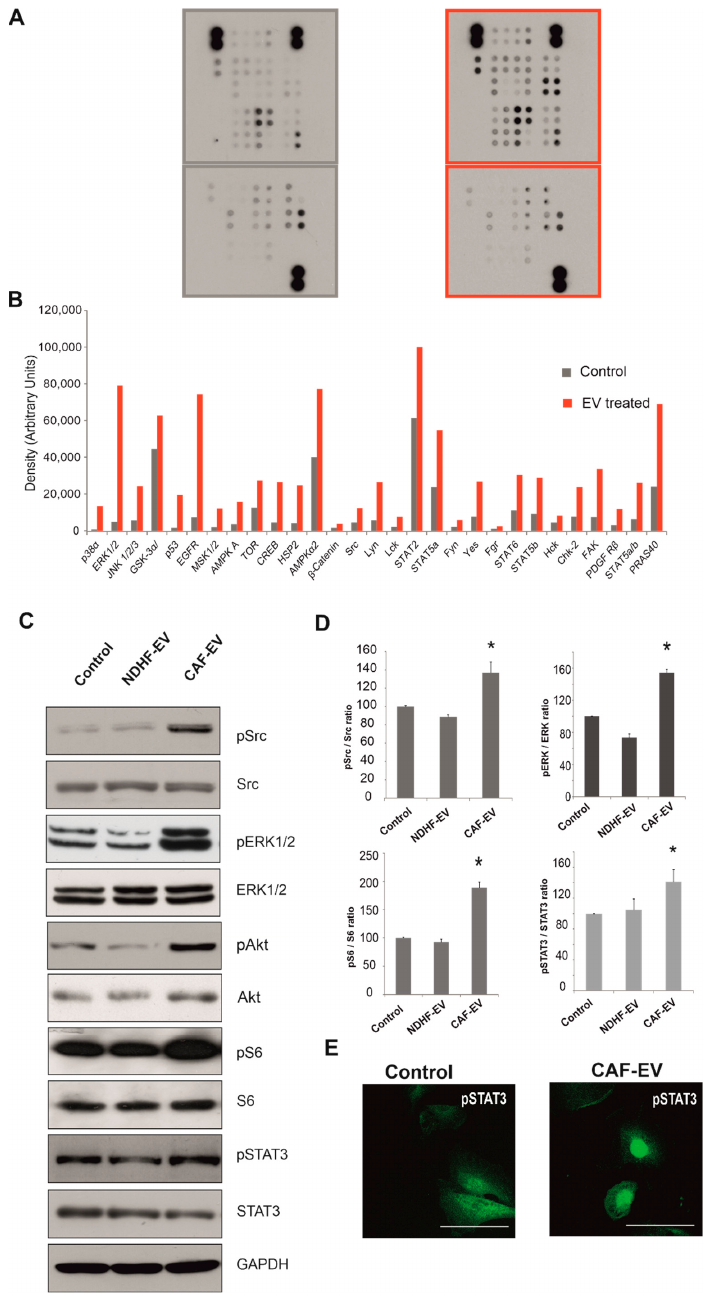
Figure 3. CAF-derived EVs induce pro-oncogenic signalling pathways in normal mesothelial cells. ( A , B ) The image shows the immunoblots of kinases in LP-9 cells treated with EVs derived from NDHFs (left) and CAFs (right, red) for 24 h. ( B ) Kinase activation status quantified by densitometry and showing induction of pro-oncogenic pathways in LP-9 cells in response to CAF-derived EVs. ( C ) LP-9 cells treated with CAF-EVs and NDHF-EVs for 24 h were analysed for phospho-Src (T416), phospho-ERK1/2 (T202/204), phospho-S6 (S235/236), and phospho-STAT3 (Y705) by western blotting and compared to untreated normal mesothelial cells (Control). Representative data from three experiments. ( D ) Quantification of phosphorylated and total protein ratios in LP-9 cells treated with CAF- EVs, NDHF- EVs or untreated (Control). Error bars show mean ± SD from three independent experiments. Statistical significance was estimated using a two-tailed Student’s t -test, * p < 0.05. ( E ). Representative image of nuclear translocation of phospho-STAT3 (Y705) protein (green) in LP-9 cells treated with CAF-EVs for 24 h. Scale bars, 50 µ